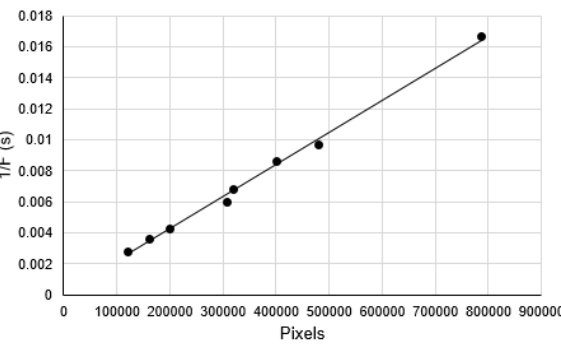
Figure 11. Inverse of maximum obtainable sampling frequency against image